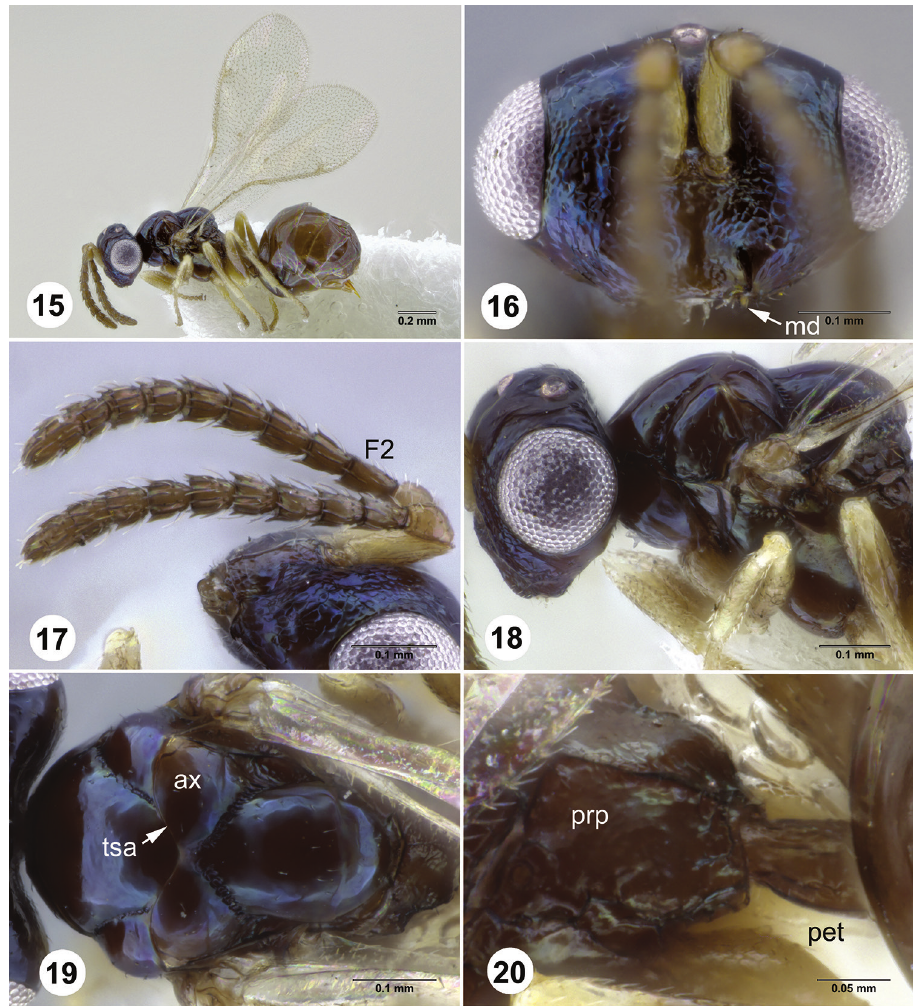
Figures 15–20. Cymosema capelina . Holotype female: 15 habitus, lateral 16 head, anterior 17 antennae, lateral 18 mesosoma, lateral 19 mesosoma, dorsal 20 propodeum and petiole, oblique dorsal. ax = axilla; F = flagellomere; md = mandible; pet = petiole; prp = propodeum; tsa = transscutal articulation. Cymosema waterworthae Burks & Mottern, sp. n. http://zoobank.org/8C723EBE-7AFA-4B38-8671-285CF7E2B443